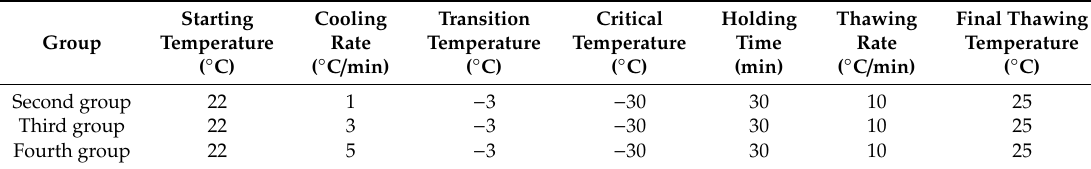
Table 2. Experimental scheme at di ff erent cooling rates.